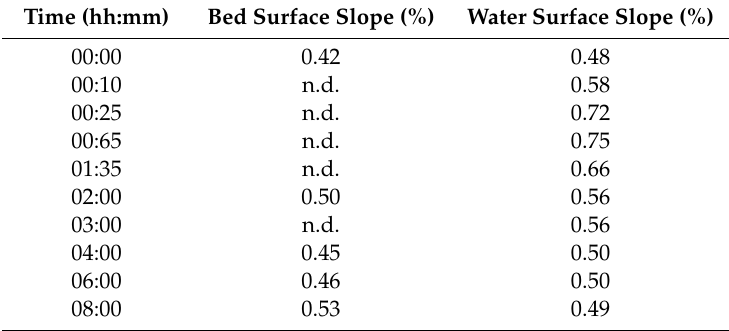
Figure A1. Volumetric analysis of the delta formation D3 and the ensuing erosion E1 during drawdown flushing. Table A2. Mean slopes of the measured bed surface levels and water surface levels for test run E2, n.d. = not